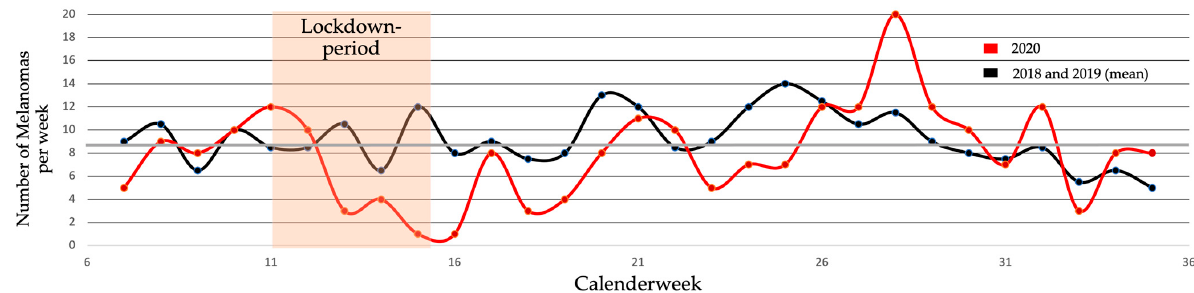
Figure 3. Number of diagnosed primary melanomas per week (mean of 2018 and 2019 compared to 2020). A marked decline in weekly melanoma diagnoses can be observed shortly after governmental lockdown measures were implemented in March 2020.